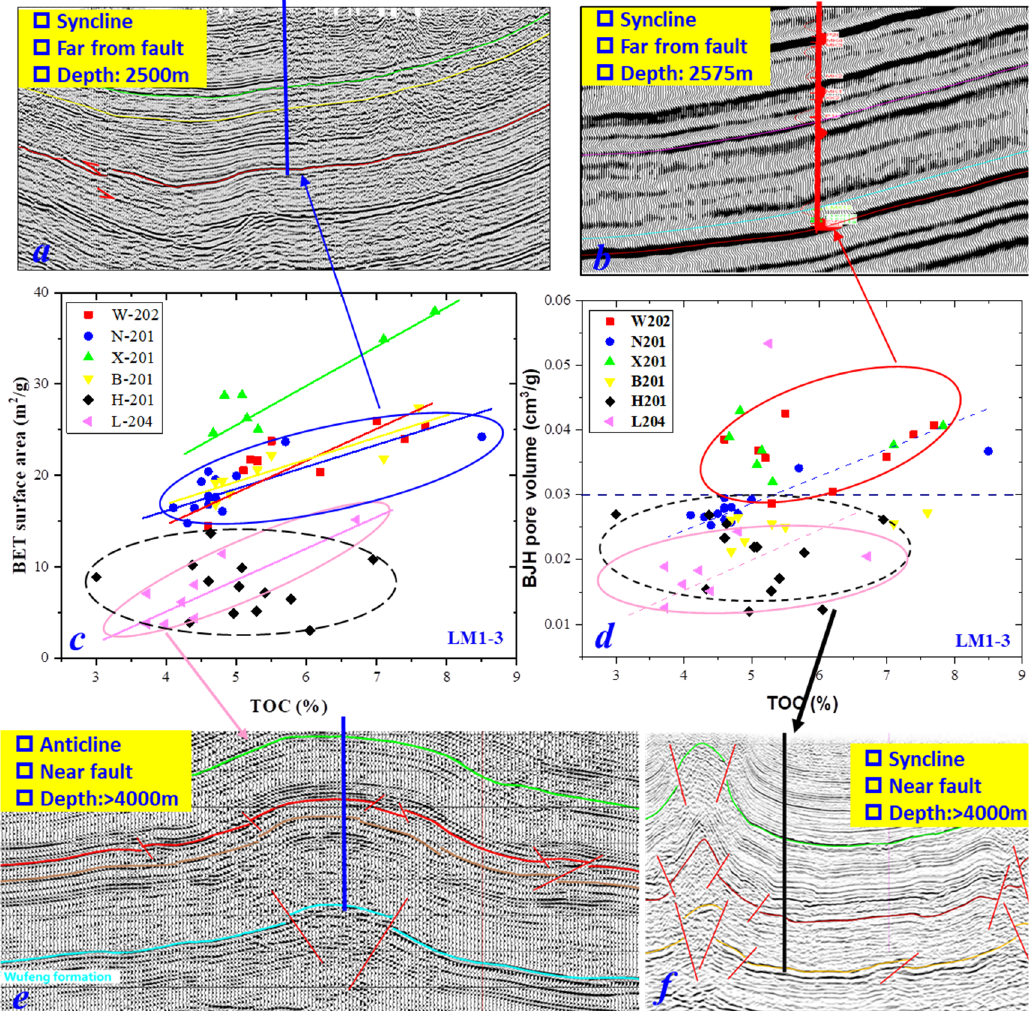
Figure 19. The geological control factors of pore volume and surface area in different shale wells. ( a , b , e , f ) : seismic cross-sections of well N201, W202, L204 and H201 wells; ( c , d ): The correlation between TOC content and BET surface area ( c ), BJH pore volume ( d ) (LM1-3 substrata).